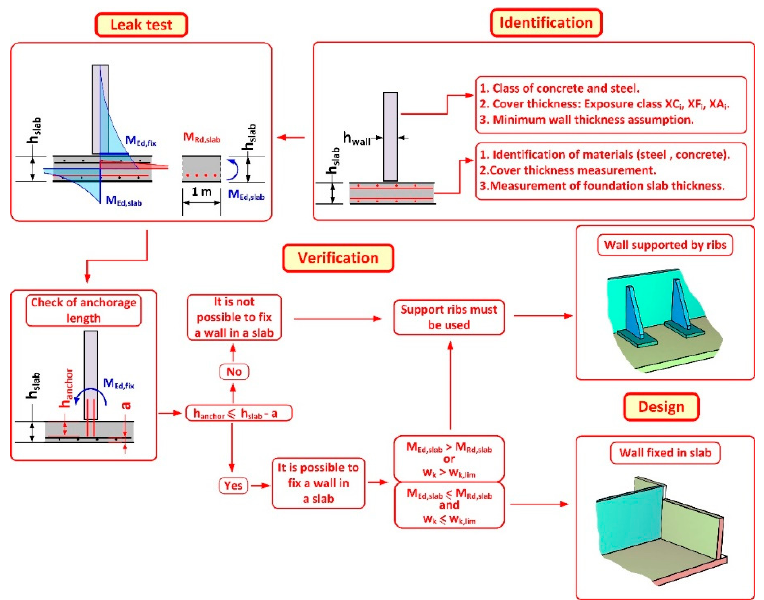
Figure 26. Proposed IVD (identification, verification, design) diagram for the design of new walls in existing reinforced concrete tanks.